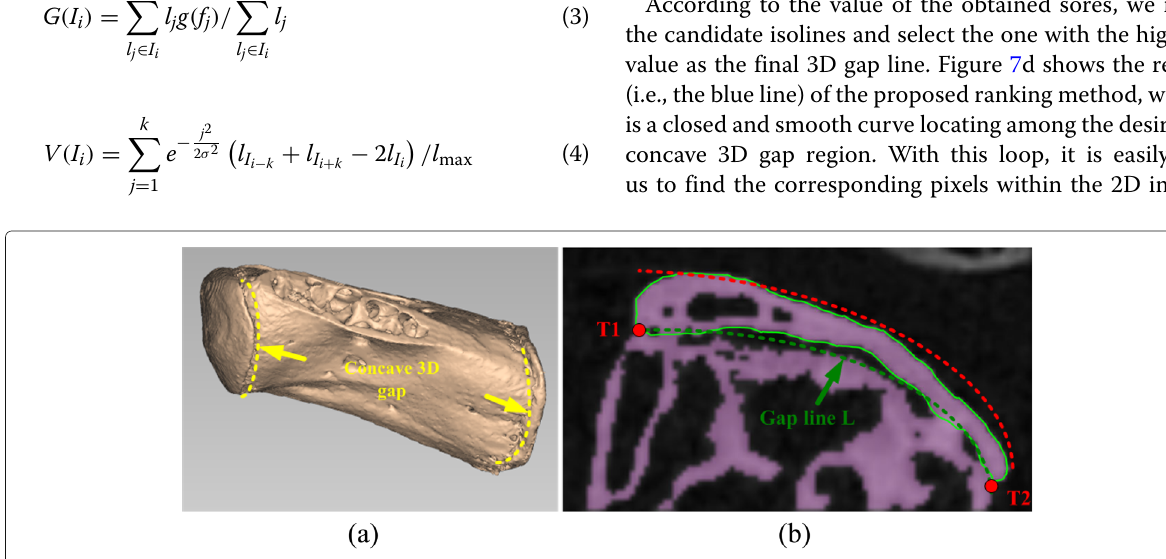
Fig. 6 Demonstration of two types of shape priori used in our method. a The first shape priori is there appears a concave gap marked with yellow dotted line between the endplate and the adjacent body in the view of 3D geometry. b The second one is the shape similarity between the internal and external edge of endplate, which can be approximated by the green and red dotted line respectively. The green dotted line is named as gap line L with two terminal points T 1 and T